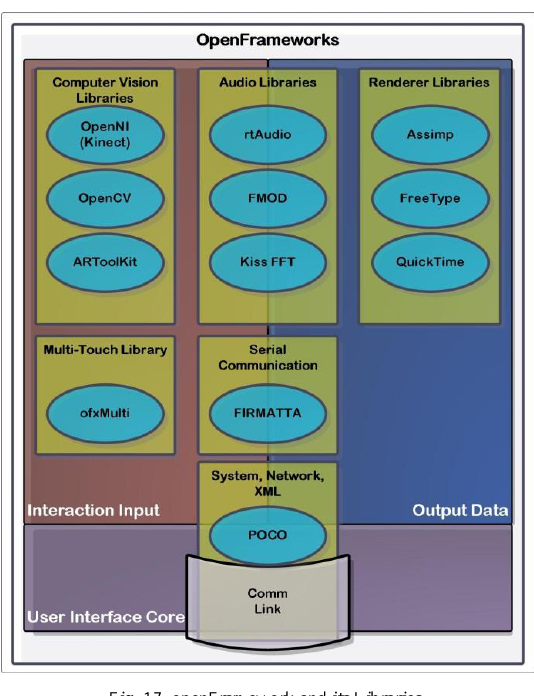
Fig. 17. openFramework and its Libraries.